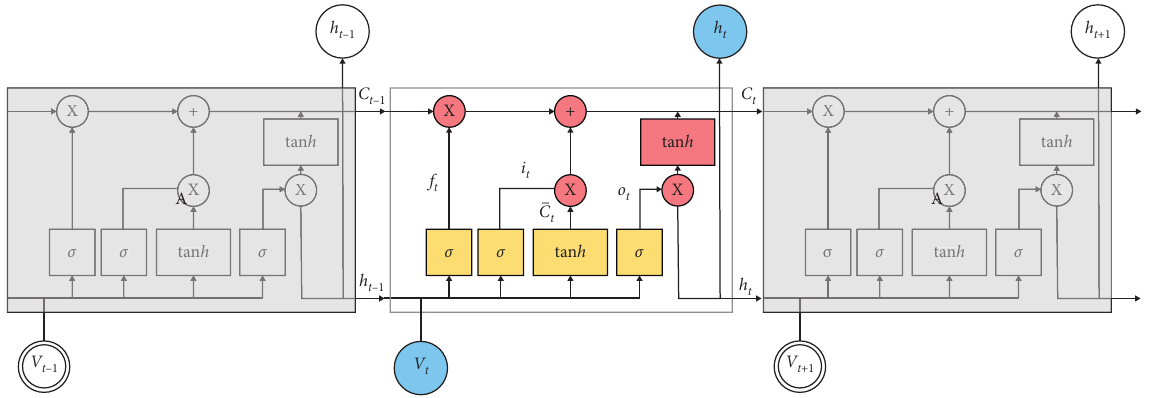
Figure 6: Repeated modules in